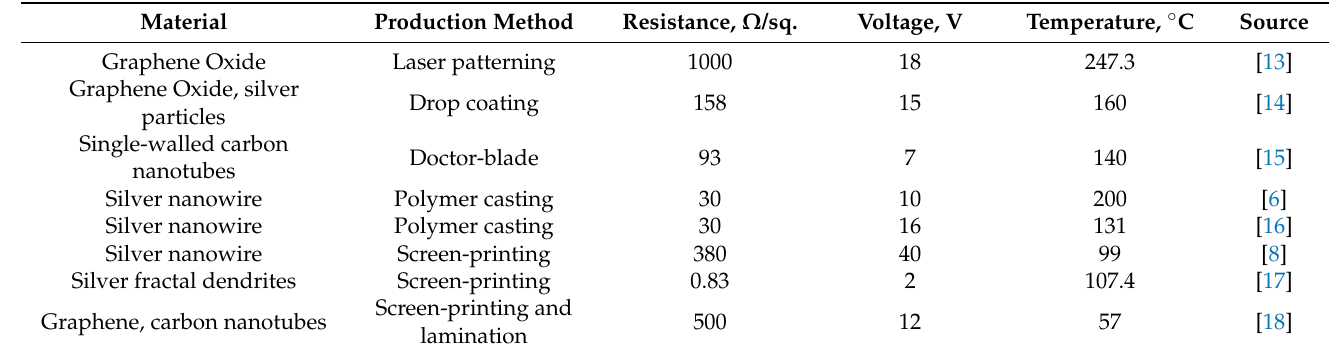
Table 1. Comparison of Materials, Production Methods, Electrical and Thermal Properties of Existing Research into Flexible Heaters. Material Production Method Graphene Oxide Graphene Oxide, silver particles Single-walled carbon nanotubes Silver nanowire Silver nanowire Silver nanowire Silver fractal dendrites Graphene, carbon